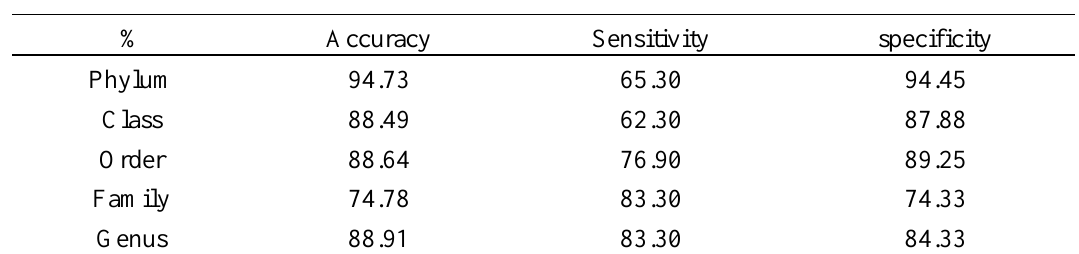
Table 3. Accuracy, Sensitivity, and specificity of clustering in RDP